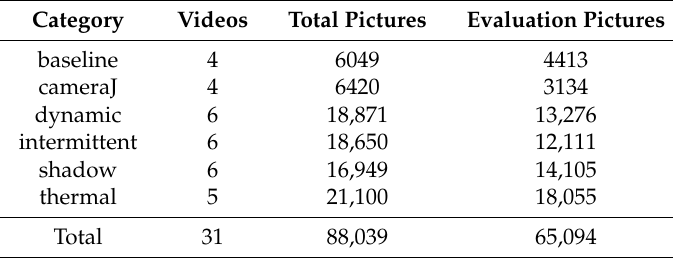
Figure 8. The CDnet2012 dataset [28]: The first row shows an original image from each category and the second row shows its corresponding ground-truth. From left to right: baseline, camera jitter, dynamic background, intermittent object motion, shadow, and thermal. Reproduced with permission from [28], Copyright Mitsubishi Electric Research Laboratories, Inc., 2012. Table 1. Overview of the CDnet2012